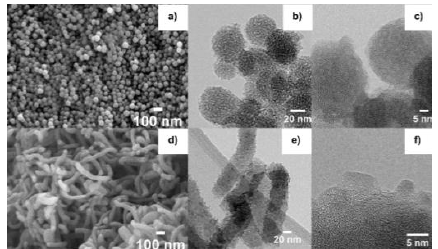
Figure 1. SEM and HRTEM images of N05-SG-SS ( a – c ) and N05-SG-SR ( d –f), respectively. SS: spherical, SG: sol–gel method, SR: rod-like. Nanomaterials 2020 , 10 , x FOR PEER REVIEW